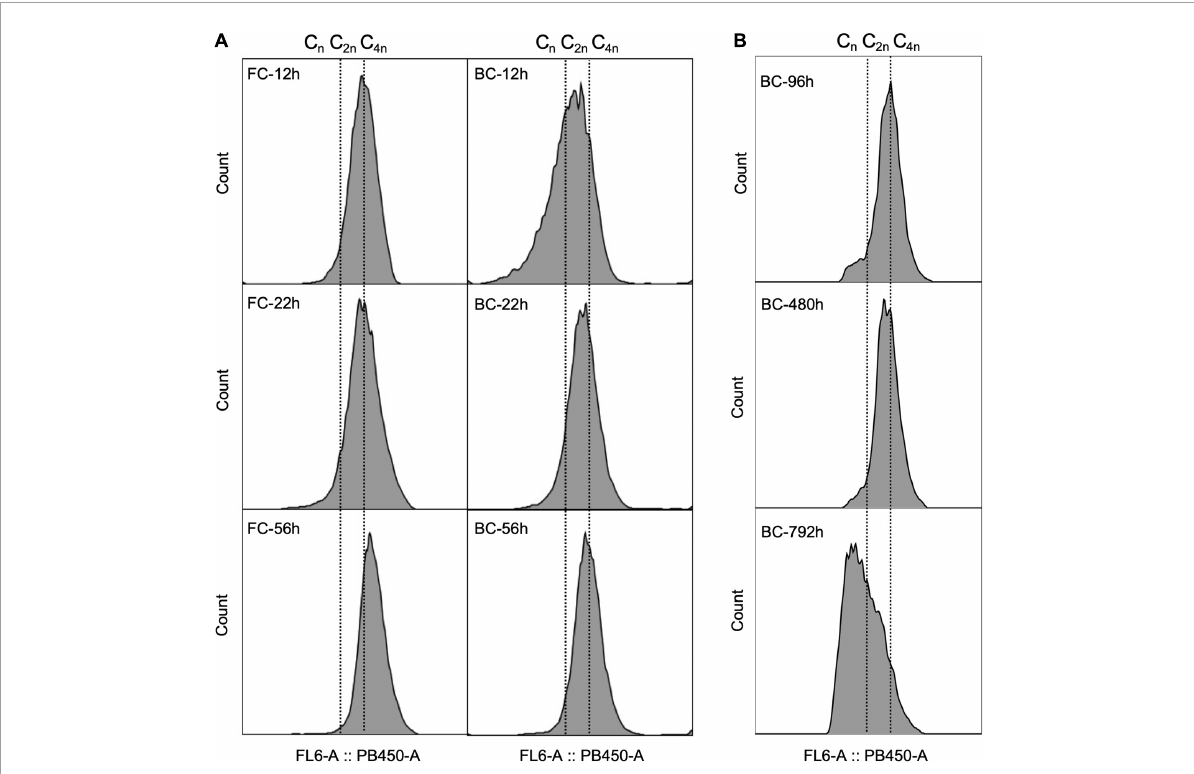
FIGURE4 Comparison of DNA patterns between C. glutamicum biofilm cells (BC) and free cells (FC) during fermentation. (A) DNA patterns of cells taken at different time points during a single-batch fermentation. The chromosome equivalents were determined according to Neumeyer et al. (2013) and expressed as C n , wherein represents the number of chromosome equivalents. (B) DNA patterns of C. glutamicum biofilm cells taken at time points of log phase during repeated-batch fermentation.